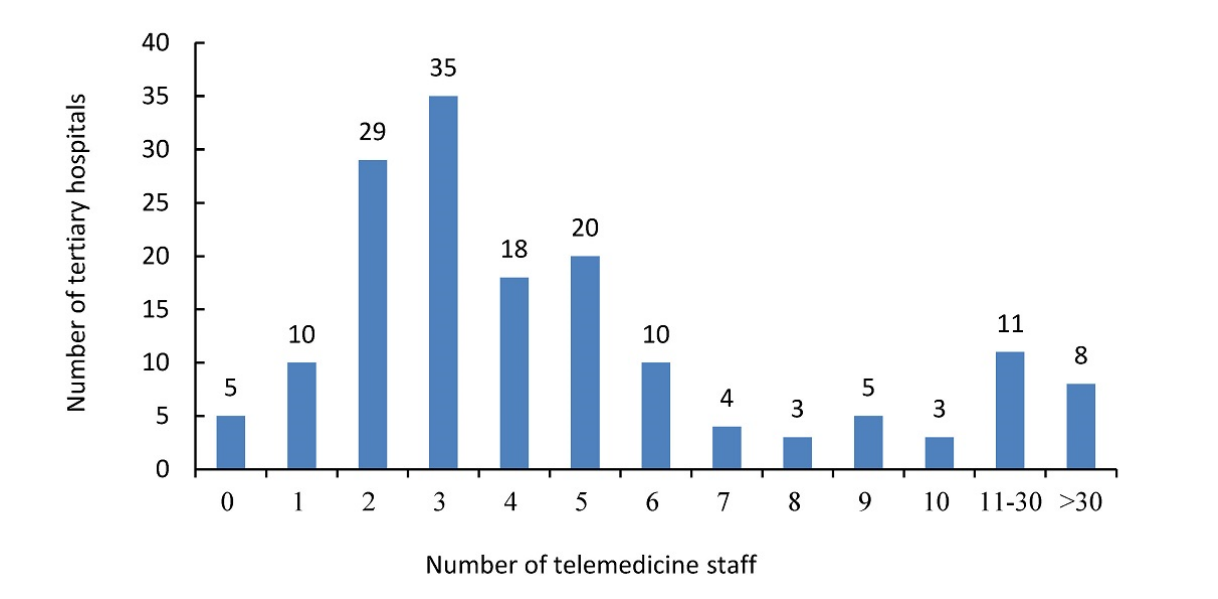
Figure 2. Distribution of the telemedicine staff in tertiary hospitals of China.